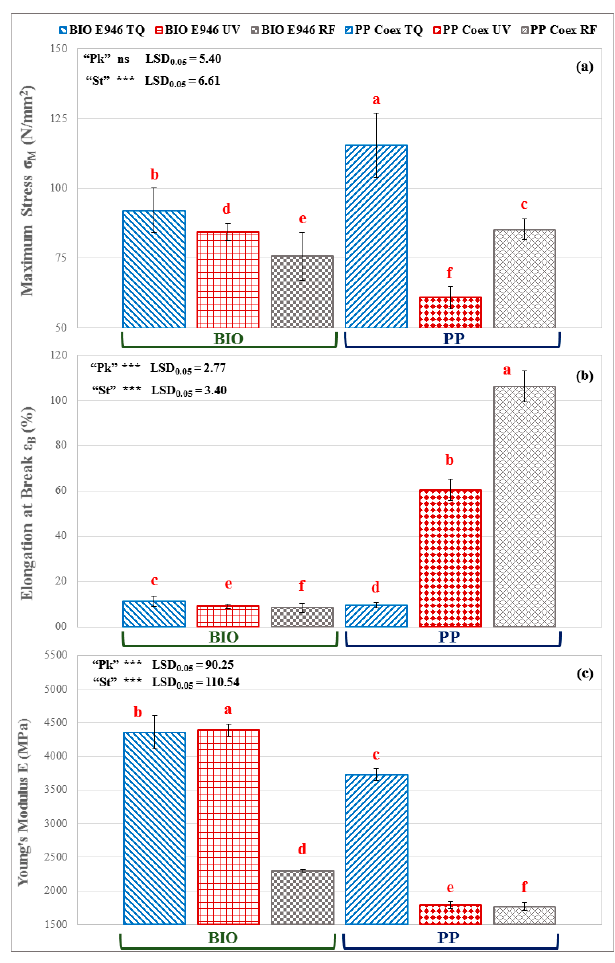
Figure 4. E ff ect of packaging film and sterilization treatment on ( a ) maximum stress, ( b ) elongation at break and ( c ) Young’s modulus of. TQ = original sample, UV = UV treated film; and RF = RF treated sample. Di ff erent red letters above bars indicate significant di ff erences at p < 0.05 (LSD test). *** Main e ff ects significant at p ≤ 0.001. ns = not significant. Error bars are also reported.